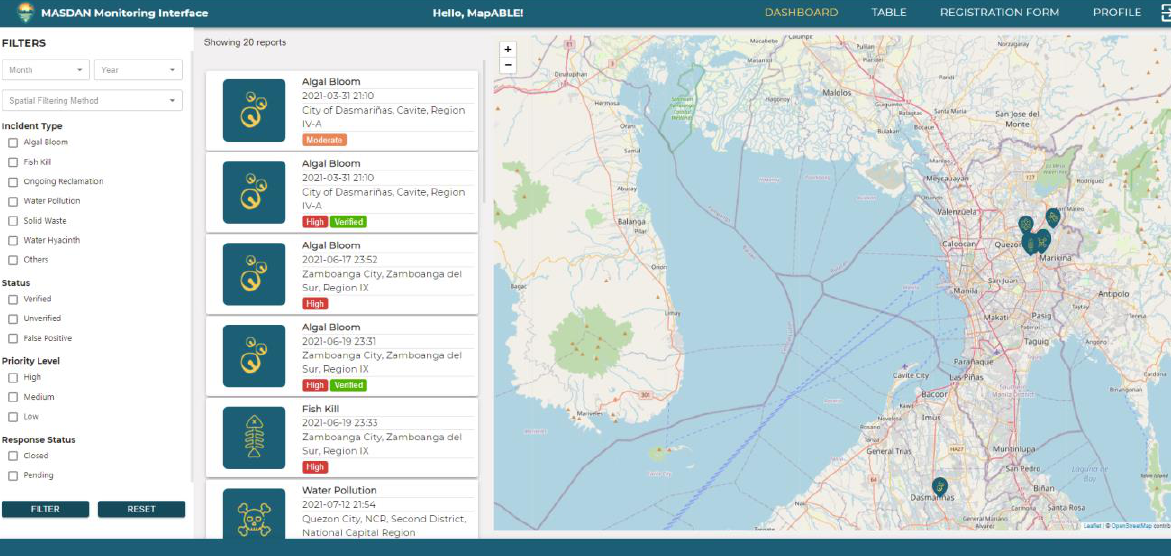
Figure 6. MASDAN Monitoring